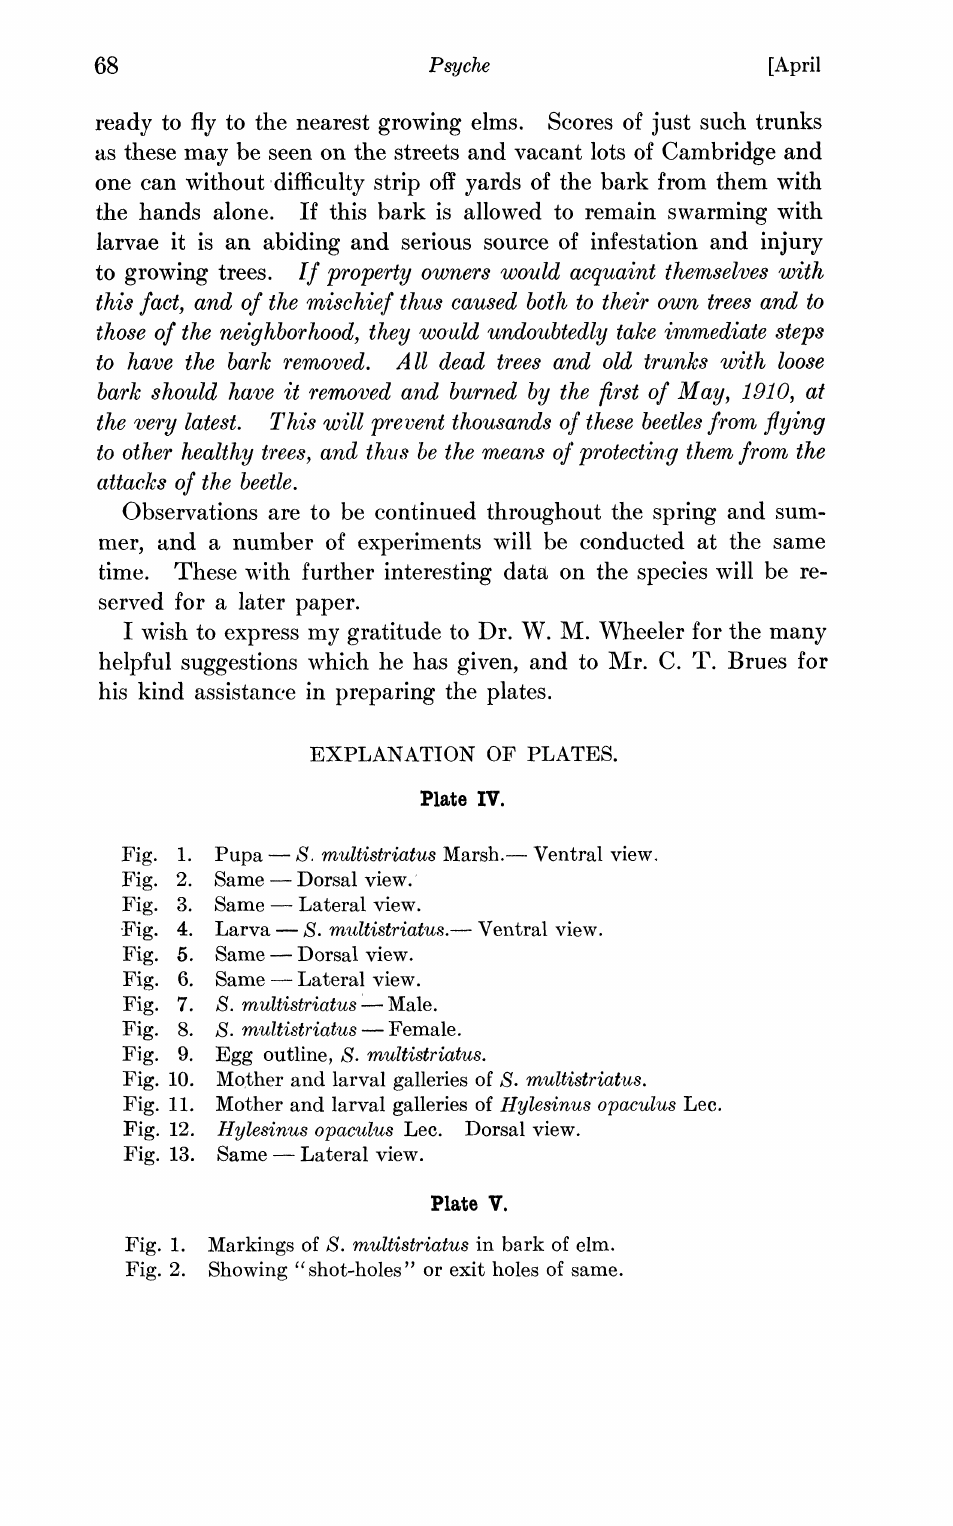
Pupa S. multistriatus Marsh.--Ventral view, Same Dorsal view.’ Same- Lateral view. Larva- S. multistriatus.--Ventral view. Same- Dorsal view. Same Lateral view. S. multistriatus Male. S. multistriatus- Female. Egg outline, S. multistriatus. Mother and larval galleries of S. multistriatus. Mother and larval galleries of Hylesinus opaculus Lec. Hylesinus opaculus Lec. Dorsal view. Same- Lateral view. Plate V. Markings of S. multistriatus in bark of elm. Showing "shot-holes" or exit holes of